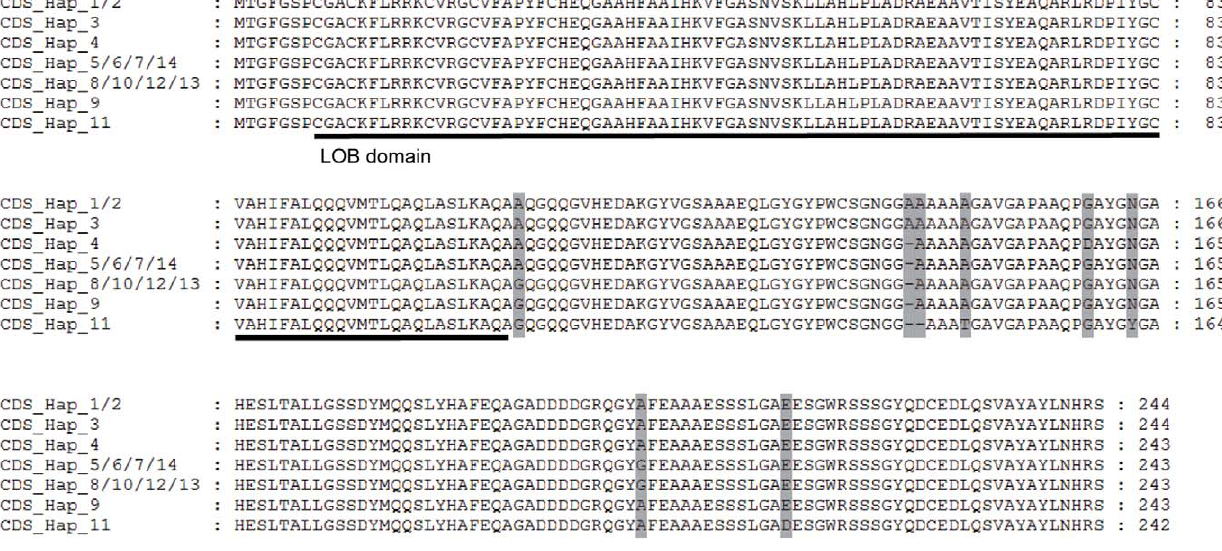
Figure 2. Sequence alignment of RTCS proteins encoded by different CDS haplotypes. The hyplotypes identified by coding sequences of RTCS gene were used as sequence name. Polymorphisms from inferred amino acid were indicated by shade.